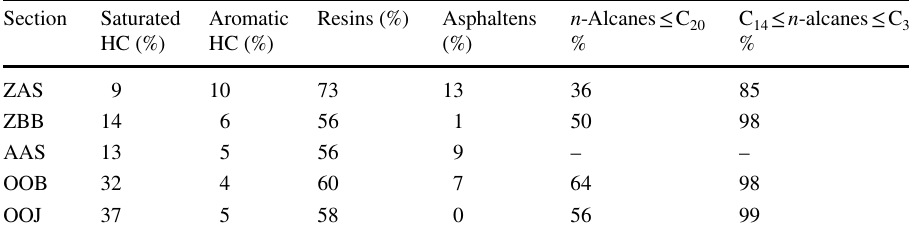
extraction compounds of Bir M’Cherga Aptian–Albian source rocks